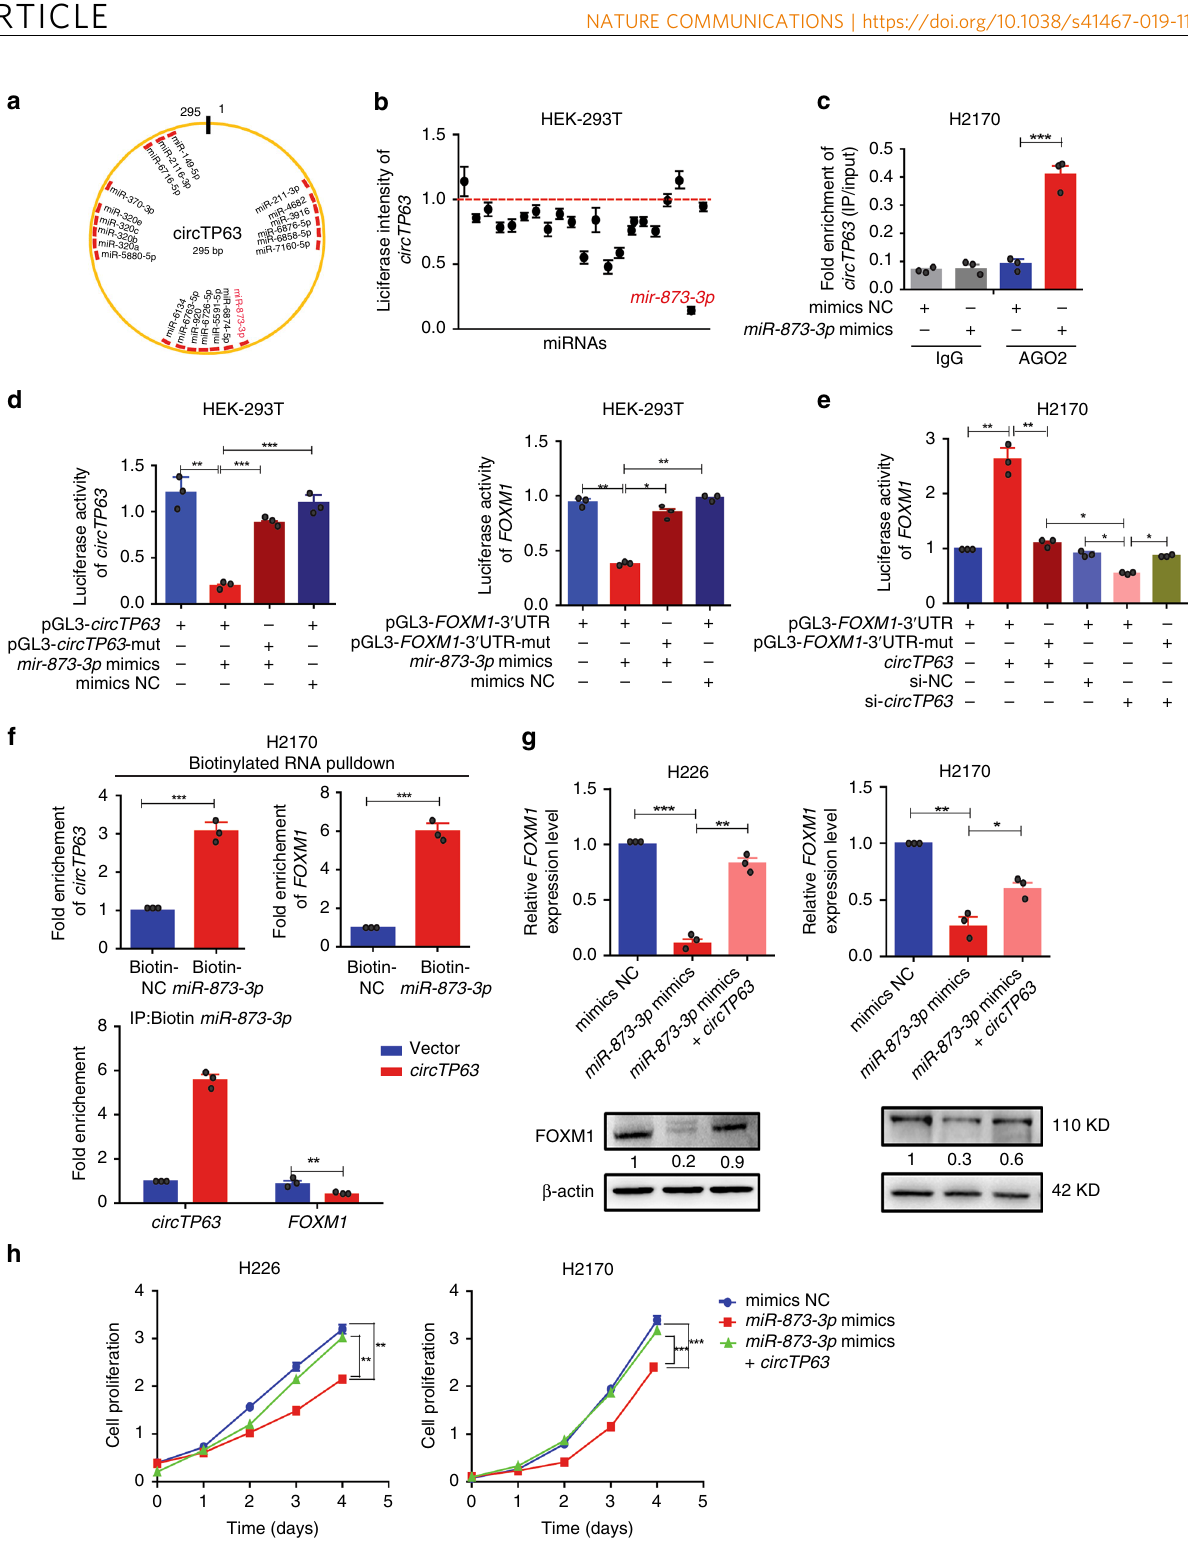
cells led to the decreased enrichment of FOXM1 on miR-873-3p (Fig. 5f, lower panel). Additionally, we also evaluated FOXM1 in cells with overexpressing miR-873-3p . Result showed that miR- 873-3p mimics signi fi cantly decreased FOXM1 , but it was rescued by circTP63 overexpression (Fig. 5g). We investigated the effect of miR-873-3p on cell proliferation. Overexpression of miR-873-3p inhibited the cell proliferation and overexpression of circTP63 could rescue miR-873-3p mimics-mediated suppression for proliferation and cell cycle (Fig. 5h and Supplementary Fig.